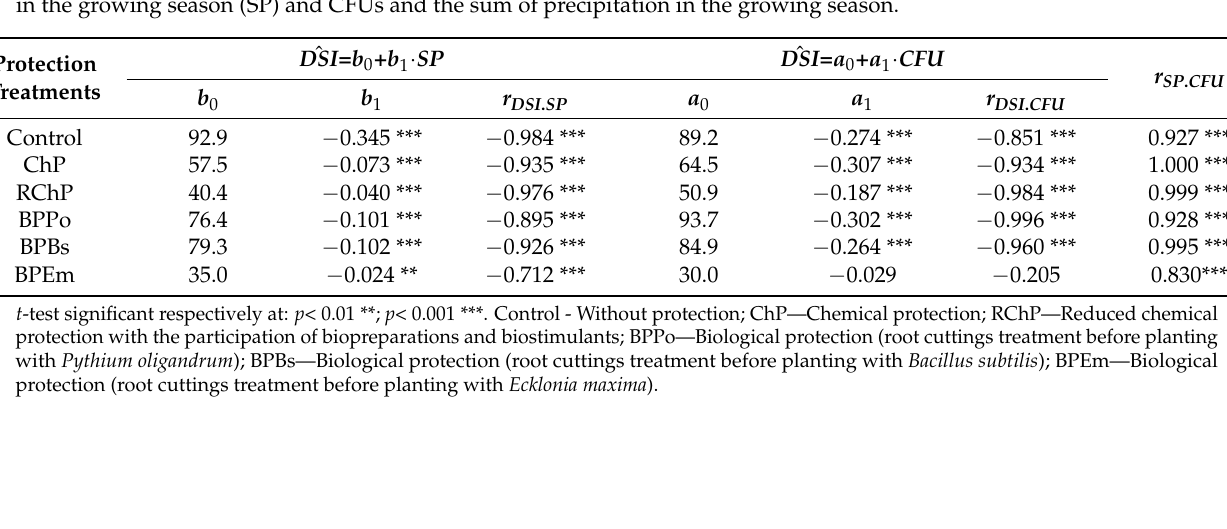
Protection Treatments